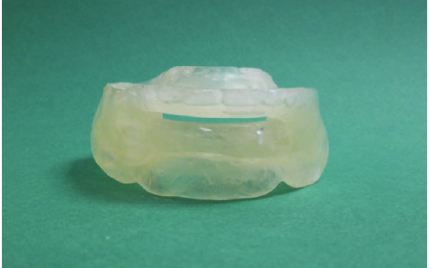
Figure 4: The appearance of MAD (out of the